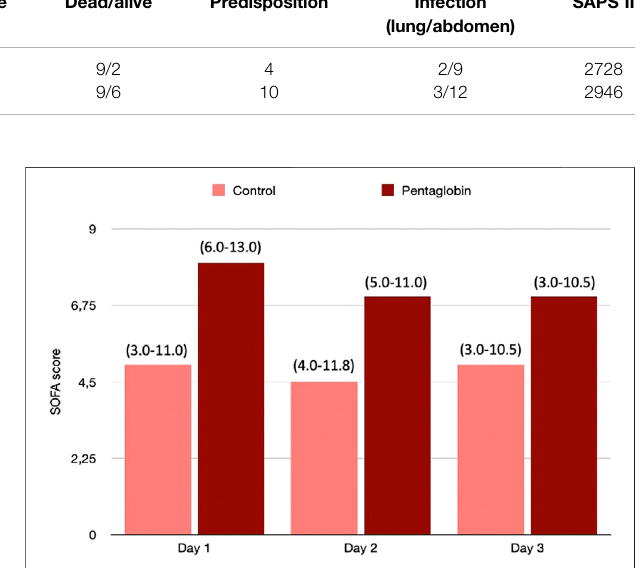
FIGURE 1 | Comparison of Nitric Oxide changes over time between Pentaglobin and control groups by linear mixed models ( p (cid:1) 0.83). The height of bars represents the median values and the numbers in brackets the corresponding interquartile range of Nitric Oxide (NO) levels determined by ozone-chemiluminescence technology in blood samples in patients receiving intravenous immunoglobulin preparation (Pentaglobin) and in those of the control group. NO was collected for the fi rst 3 days from sepsis diagnosis after ICU admission. The use of Pentaglobin did not signi fi cantly in fl uence the temporal evolution of NO( p (cid:1) 0.83) versus the standard therapy, although a decreasing trend of NO level at the end of the third day by more than 50% was observed in the treated group compared to the control group. The between-groups comparison over time was performed by linear mixed models. See text for more details.